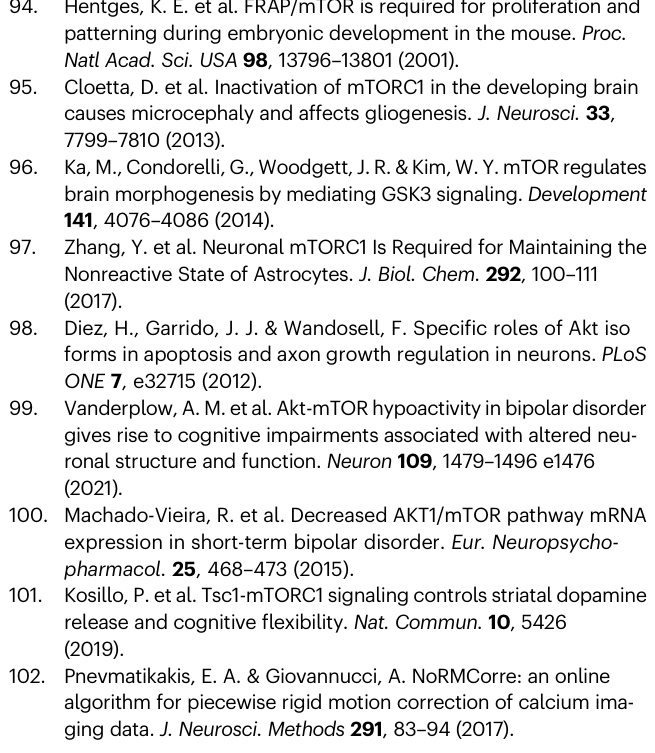
algorithm for piecewise rigid motion correction of calcium